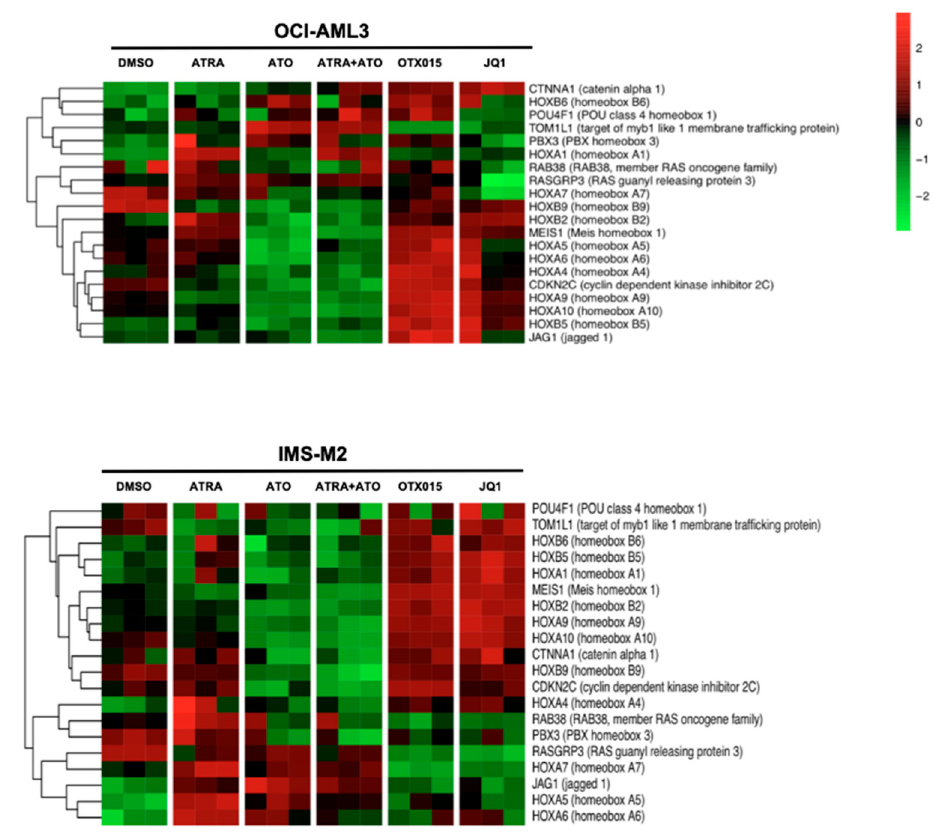
Figure 8. HOX gene cluster signatures in NPM1c OCI-AML3 and IMS-M2 cell lines after treatment with BETi and ATO + ATRA. GeneChip Human Transcriptome Array HTA 2.0 (Affymetrix ® ) was performed for OCI-AML3 and IMS-M2 cell lines. Experiments were performed as triplicates. Heatmap of the specific HOX signature [10] of cells either treated with 0.1% DMSO, 1000 nM ATRA, 1000 nM ATO, 1000 nM ATO + 1000 nM ATRA, 500 nM OTX015 (MK-8628), or 500 nM JQ1.